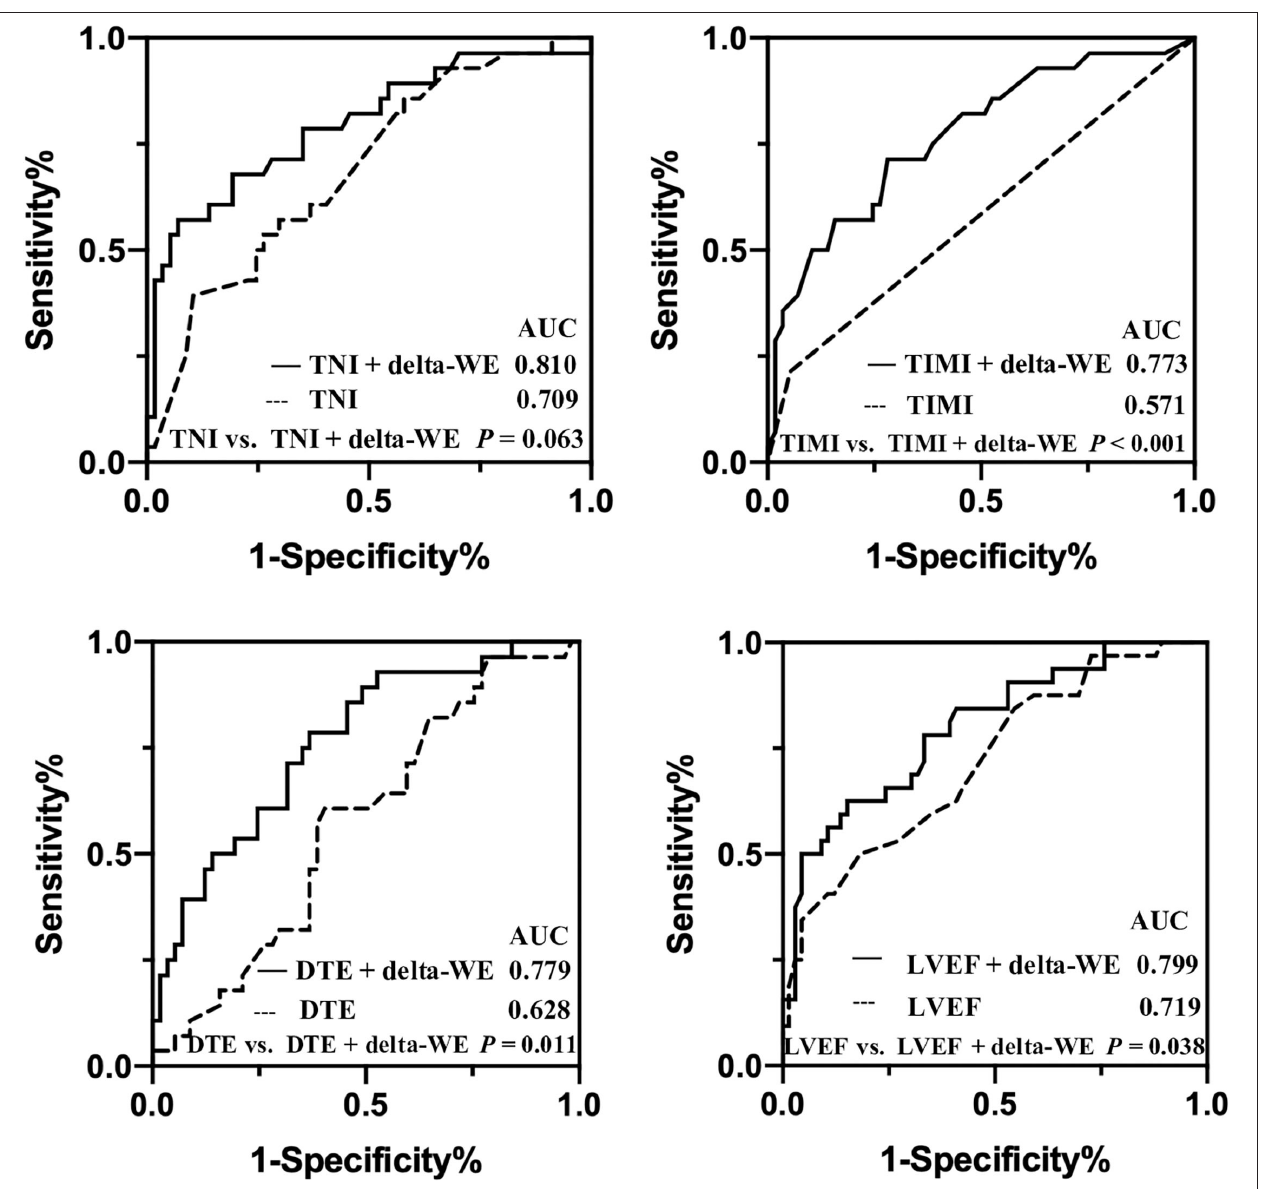
FIGURE 5 | Comparisons of receiver operating characteristic curves of baseline traditional clinical risk factors with and without delta-WE to predict early left ventricular remodeling in anterior STEMI patients. AUC, area under the